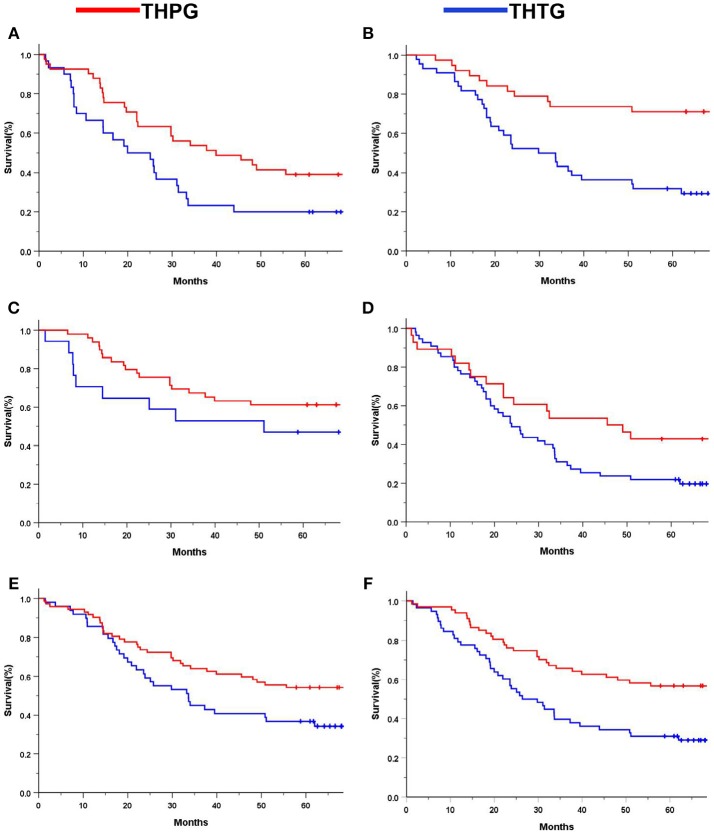
Kaplan-Meier curves of subgroup analysis by treatment. (A). Type GE (log-rank P = 0.002); (B) Type G (log-rank P = 0.000); (C) Well-differentiation (log-rank P = 0.068); (D) Poor-differentiation (log-rank P = 0.005); (E) ECOG-PS0 (log-rank P = 0.003); (F) D2/D2+ (log-rank P = 0.000). EGJ, Esophagogastric Junction; THTG, Transhiatal Total Gastrectomy; THPG, Transhiatal Proximal Gastrectomy; Type GE and Type G, “E-G” Subtype according to Nishi's classification; ECOG-PS, Eastern Cooperative Oncology Performance Score; D2/D2+, D2/D2+ lymphadenectomy according to the EGJ cancer with Type GE.